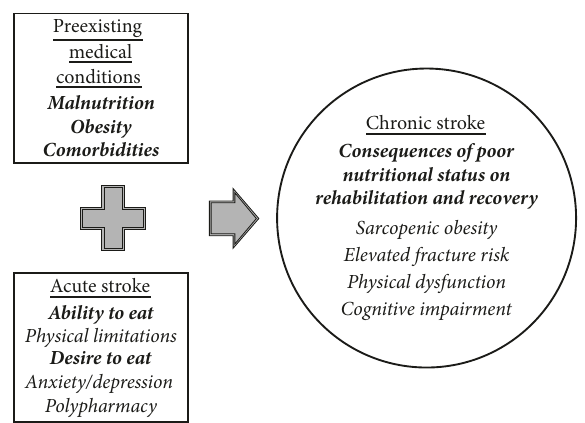
Figure 1: The impact of preexisting medical conditions and acute stroke consequences on dietary intake and nutritional risk during chronic stroke